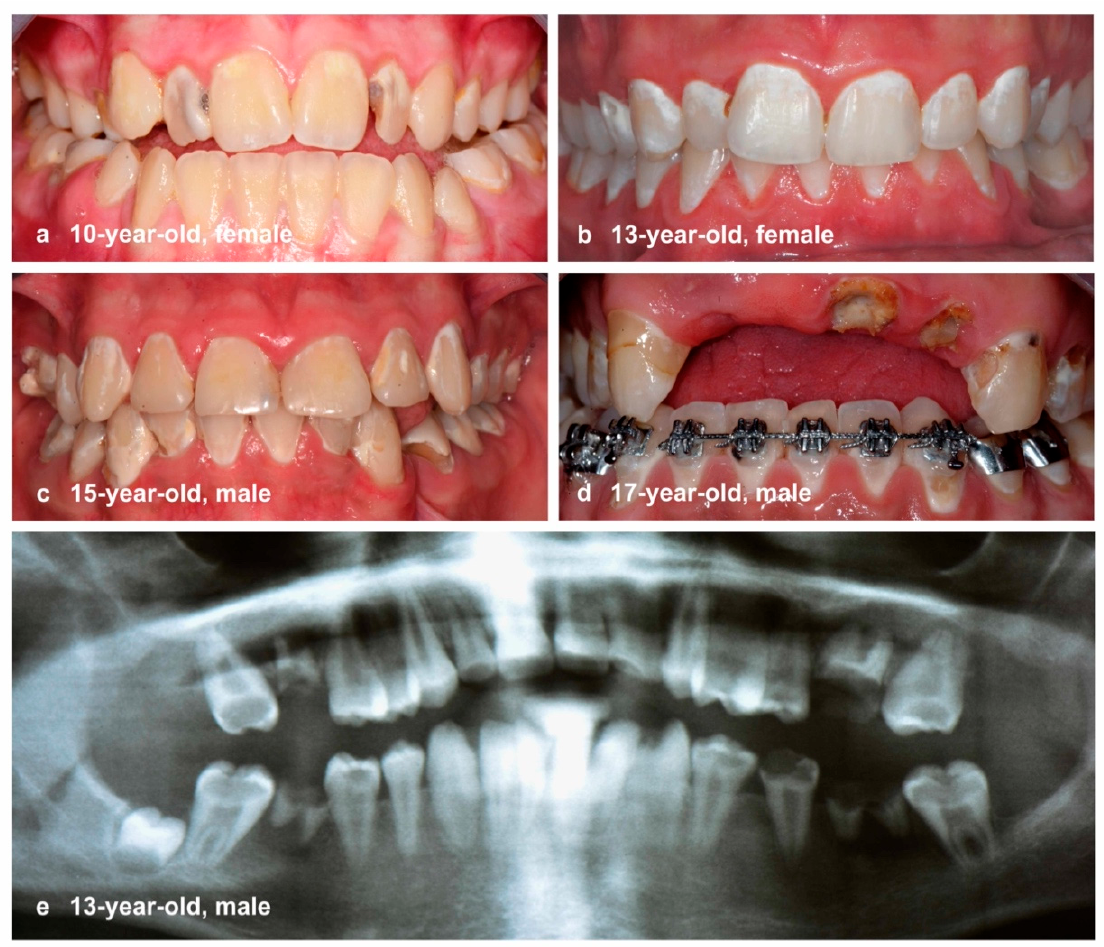
Figure 1. Clinical situation of severely caries-affected adolescents: multiple non-cavitated and cavitated caries lesions with typical additional individual risks: ( a ) mental health issues; ( b ) no medical history; ( c ) suspected uninvolved parenting (neglect); ( d ) suspected drug abuse and mental health issues; and ( e ) syndromic disease.